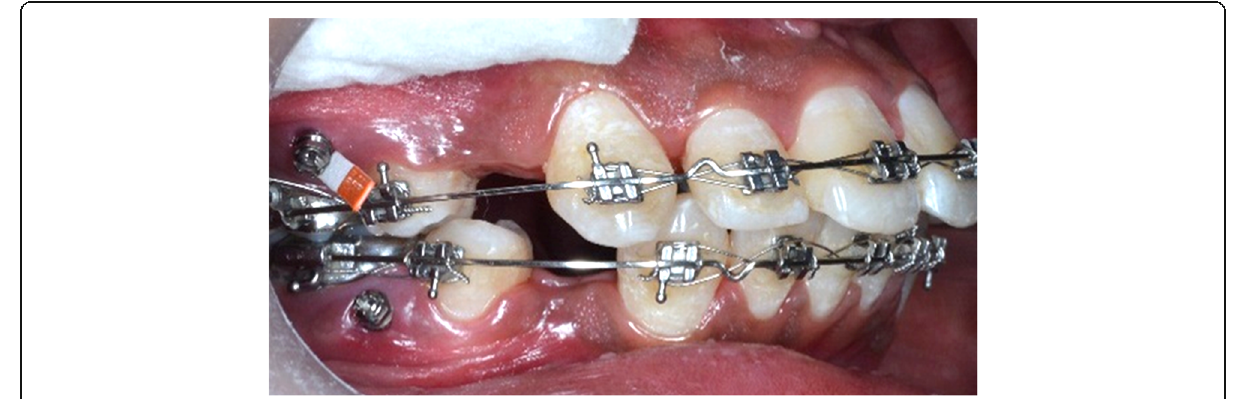
Fig. 2 Sample collection by periopaper at the miniscew implant